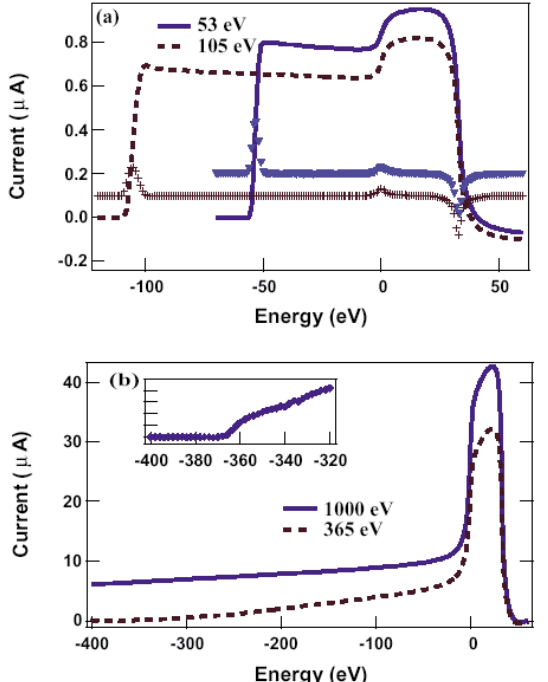
FIG. 5. (Color) (a) Transmission curves for the idealized case of monoenergetic electrons with perpendicular incidence angle. The differentiated signals are also shown. (b) Transmission curves for the more realistic case of monoenergetic electrons scattered from an Al target. The inset shows the differentiated signal for the 365-eV beam near the transmission threshold.